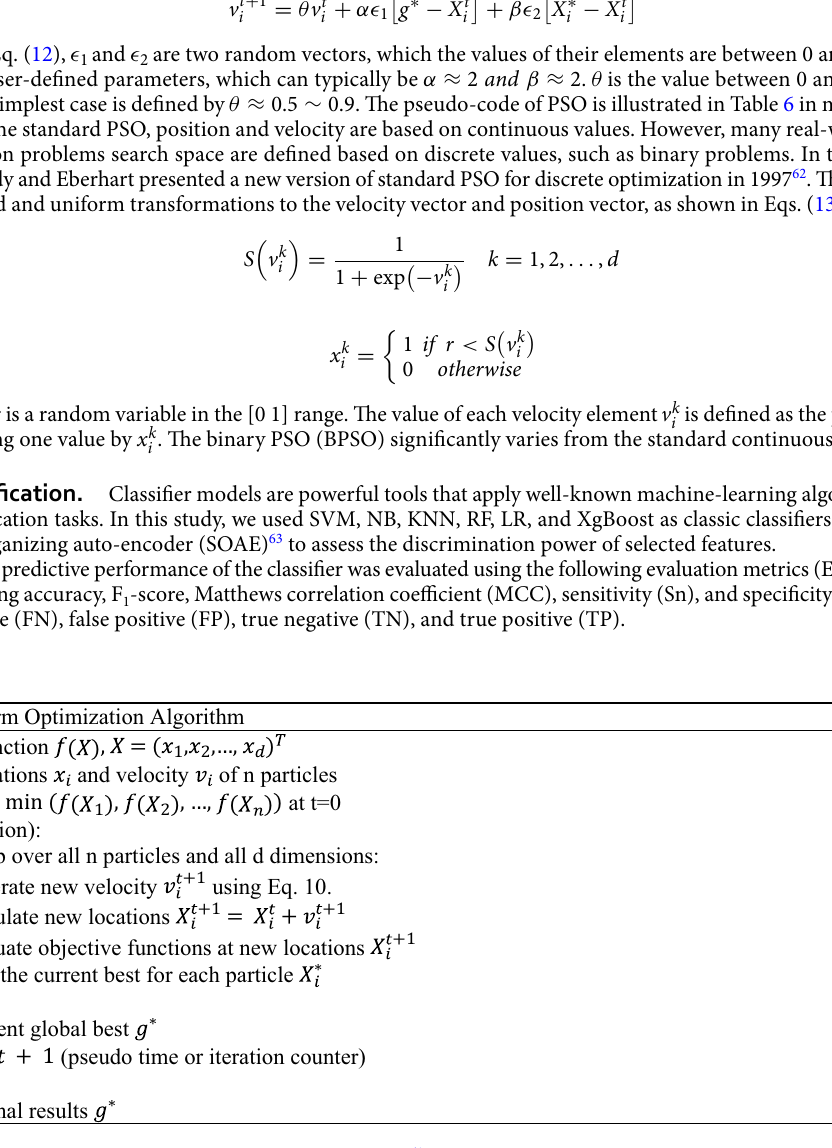
Table 6. Pseudo code of particle swarm optimization 61 .